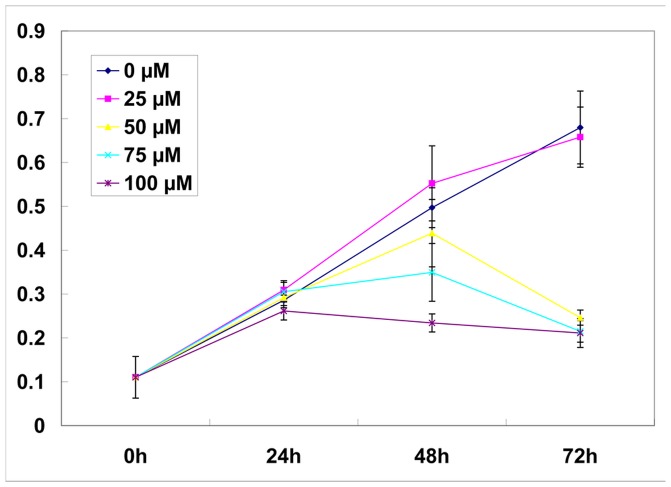
Effects on proliferation of C18-4 cell line by gradient Curcumin treatment.The relative cell number was reflected by MTS assay (Mean ± SD, n = 3). At successive time point, the relative cell number in the 25-µM Curcumin group was similar to that in the control group (0 µM Curcumin) (p>0.05). In the 50-µM Curcumin group, cell reduction became apparent at 72 h (p<0.05).In the 75-µM and 100-µM groups, the negative effect by Curcumin was manifest since 48 h (p<0.05).